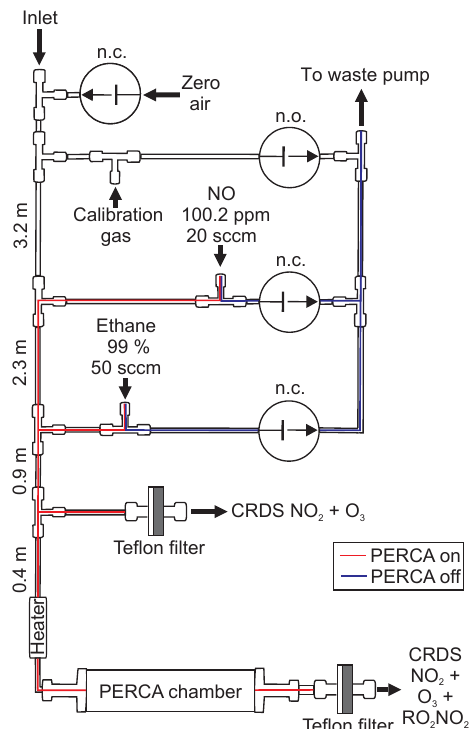
Figure 1. Schematic of the dual-channel thermal decomposition peroxy radical chemical amplification inlet. The inlet consists of a 60cm long, 0.635cm (1 / 4in.) o.d. quartz heater and an 80cm long, 1.27cm (1 / 2in.) o.d. FEP Teflon ™ reaction chamber. Reac- tion gases were added upstream of the PERCA chamber by closing the normally open valves connected to a waste pump via 50µm crit- ical orifices. Background NO 2 levels were monitored in a parallel detection channel by tapping into the inlet prior to thermal dissoci- ation of peroxy nitrates.